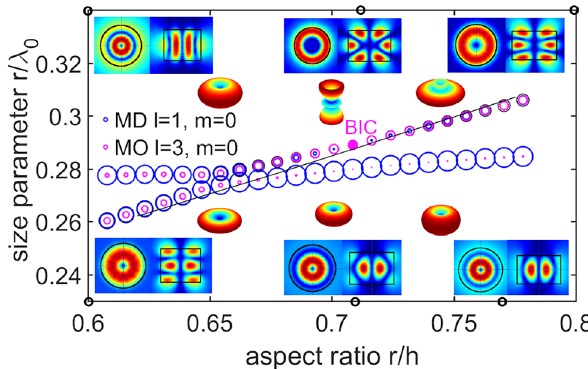
Figure 2: Dispersion of the axially symmetric eigenmodes of the AlGaAs nanodisk. Colored circles depict the multipolar decomposition of these modes: magnetic dipole (MD – blue) and magnetic octupole (MO – pink), sizes of circles scale their relative contributionsandradiativedecay.Theupperbranchtracesthehigh- quality mode and features a special point in the parameter space ( r / h = 0.71, r / λ 0 = 0.29), where the quality factor of this mode reachesitsmaximum.The fi lledpinkdotmarksthisquasi-BICpoint, it corresponds to pure MO. Insets show near- fi eld distributions of the electric fi eld magnitude and far- fi eld diagrams: the top row corresponds to the high-quality mode at r / h = 0.6, 0.71 (BIC), 0.8; the bottom row corresponds to the low-quality mode at r / h = 0.6, 0.71, 0.77. The corresponding values of aspect ratio are marked by dots at the horizontal axis. The overlaid black line sketches a dispersion branch of the mode near the second-harmonic frequency (the wavelength is doubled for direct